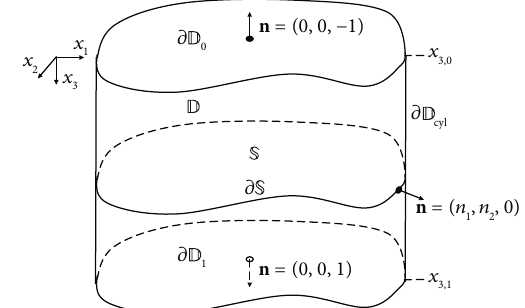
Figure 1: Con fi guration with the x 3 -direction as the preferred direction. In the lateral direction, this con fi guration can be bounded (for wave guides) or unbounded (for example, for geophysical re fl ection imaging applications). For the 2D situation, the con fi guration is a cross section of the 3D situation for x 2 = 0